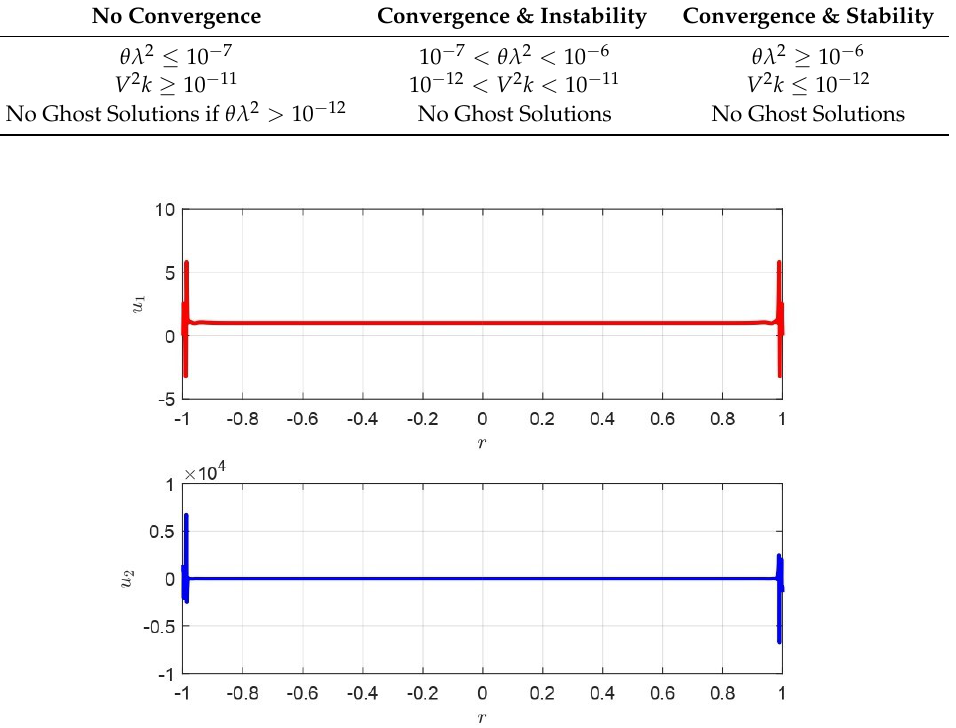
Figure 6. Recovering of the membrane achieved by u 1 = 0.1 and θλ 2 = 5 · 10 − 7 : strong instabilities take place next to the edge of the membrane.